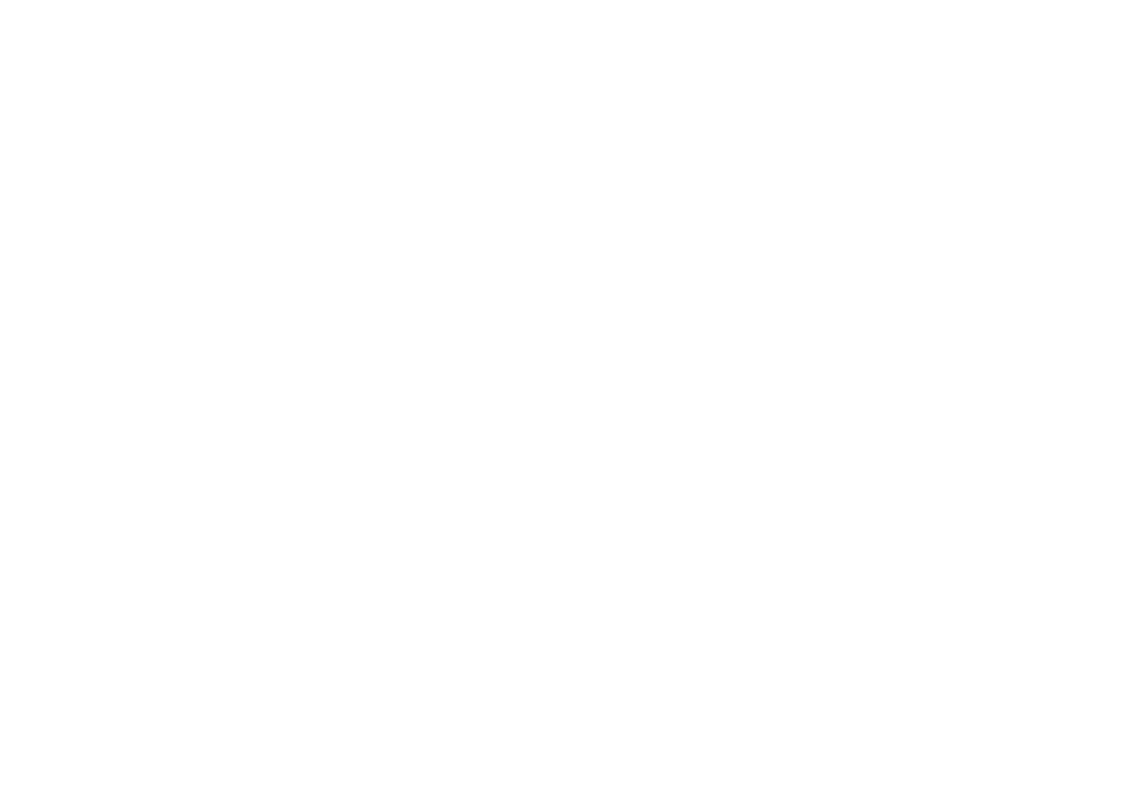
Figure 13. Effect of the order of roundness error in the rollers on the run-out variation of the inner